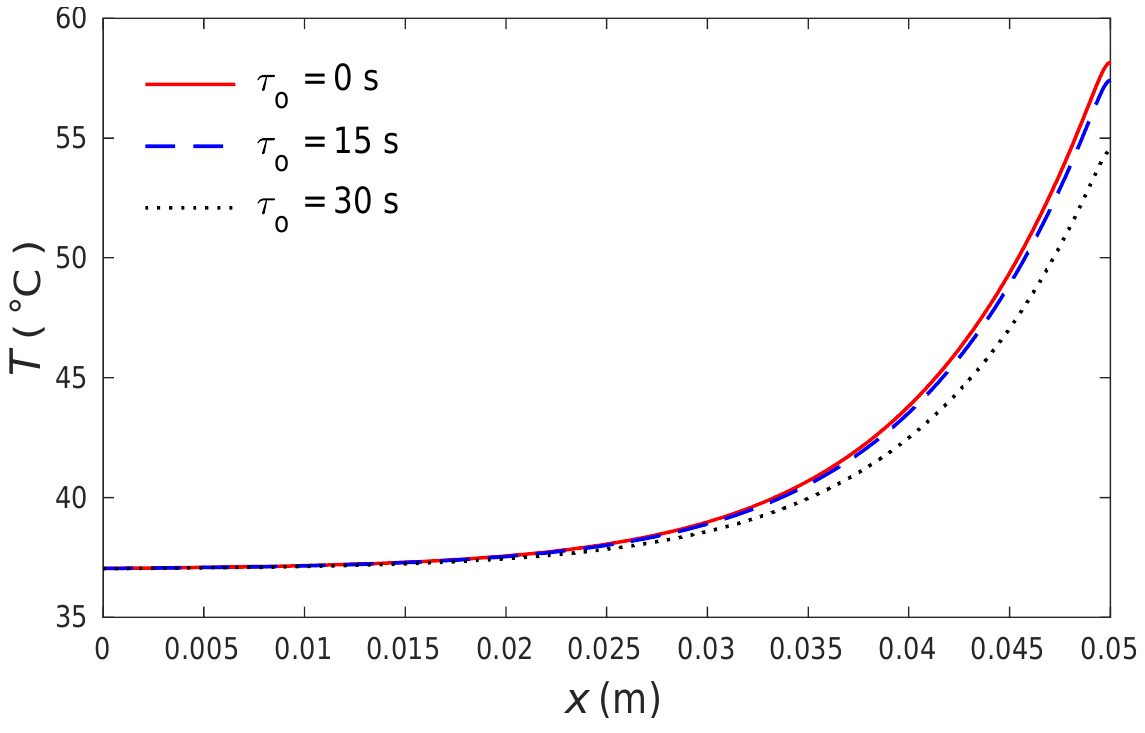
Figure 3. Temperature distributions along the distance for several values of 𝜏 𝑜 .